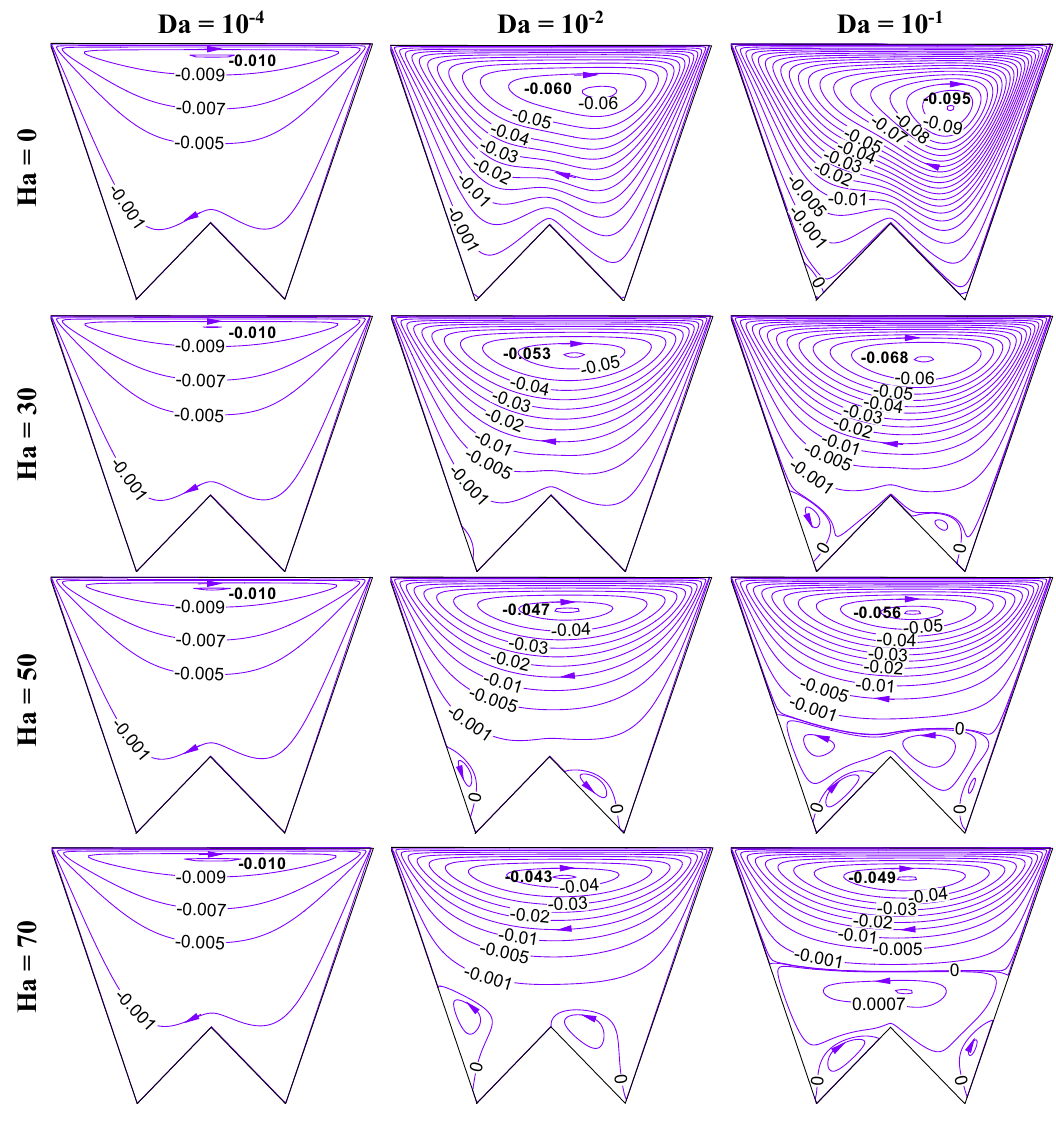
Figure 15. Contours of streamline ( ψ ) at R b = 50, Le = Pe = 1, Gr = 10 3 , m = 1, (cid:31) = 0.3, γ =